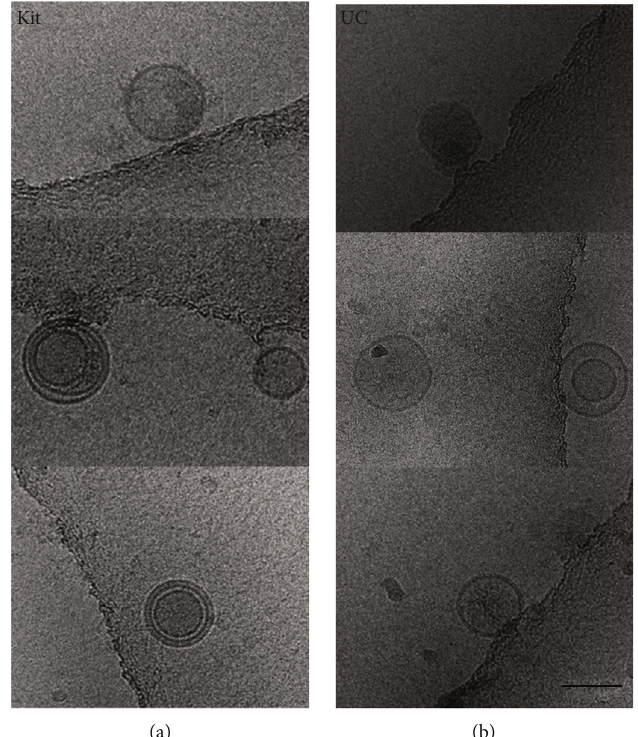
Figure 1: Cryo-EM micrographs. The images show vesicles with sizes similar to exosomes isolated using the kit (a) and UC (b). The vesicles are round and bilayered. The images were obtained at 200kV on a direct electron detector. Images were recorded at 3 μ m under focus, with an electron dose of 15e/Å2 and a nominal magni fi cation of × 25,000 ( n = 1 ) (scale bar 100 nm) (OMNI-Electron Microscopy, University of Otago).